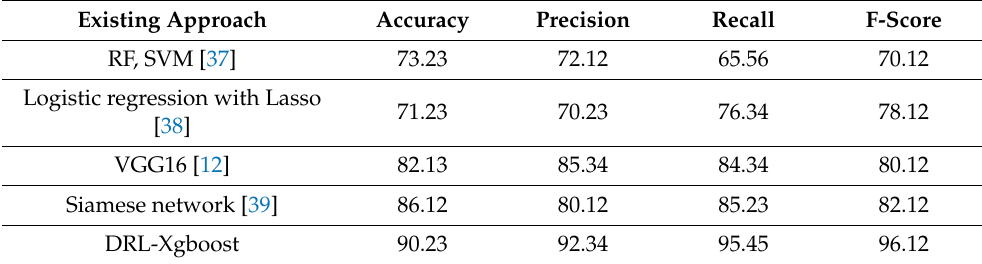
Table 5. Accuracy and precision of existing